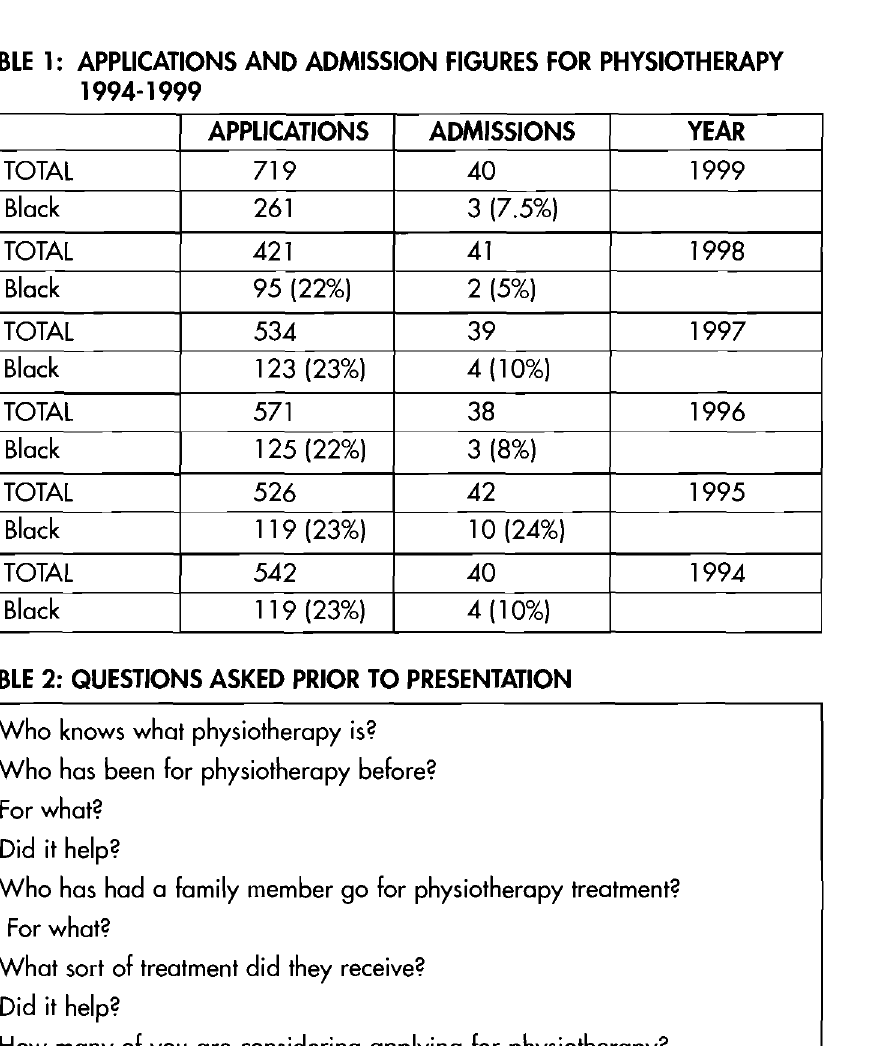
TABLE 2: QUESTIONS ASKED PRIOR TO